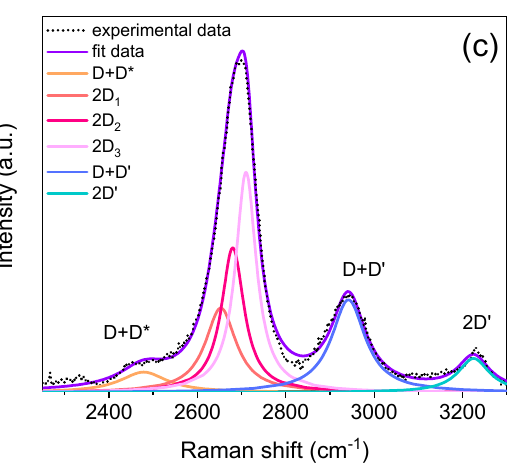
Figure 4. ( a ) Raman spectra acquired on the composite powders after high-energy planetary ball milling and on the sintered composite, inset: detail of the Raman spectrum acquired on the sintered composite in the range 150–1800 cm − 1 ; ( b ) Deconvolution of the first-order Raman spectrum of the sintered composite; ( c ) Deconvolution of the second-order Raman spectrum of the sintered composite (D + D*, 2D 1 , 2D 2 , 2D 3 , D + D’ and 2D’ bands).